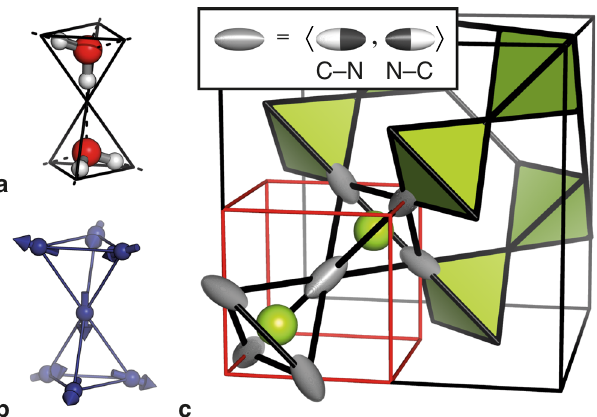
Fig. 1 Ice rules on the pyrochlore lattice. a Hydrogen-bond orientations in water ice and b magnetic moment orientations in rare-earth spin-ices both obey the same ‘ two-in-two-out ’ rule for each tetrahedral unit of the pyrochlore lattice (black lines). The same rules are thought to apply to cyanide ion orientations in Cd(CN) 2 , the crystal structure of which is represented in c . Cd atoms shown as green spheres and CN – ions as ellipsoids; the unit cell (outlined in red) corresponds to one octant of the underlying pyrochlore lattice (outlined in black). For clarity, only one of the two interpenetrating pyrochlore lattices is shown. In the average structure of Cd(CN) 2 , CN – orientations are disordered (grey). This disorder is not random: there is a preference for each Cd to bind two C atoms (white hemiellipsoids) and two N atoms (black hemiellipsoids) in an ice-like ‘ two- in-two-out ’